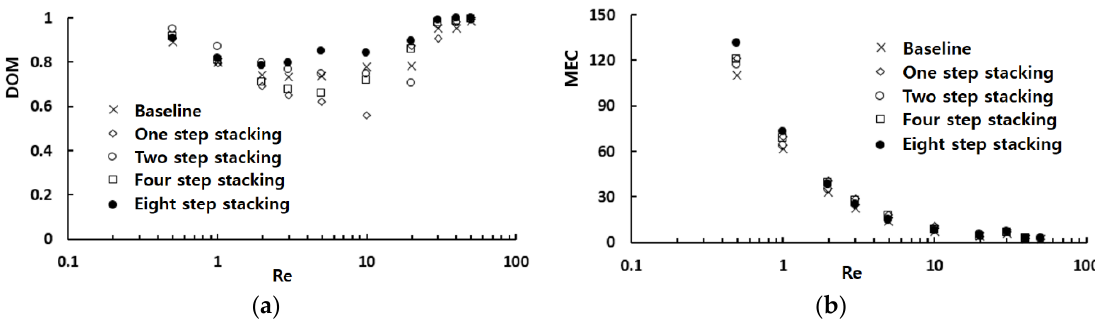
Figure 6. Effects of mixing unit stacking on the mixing performance. ( a ) DOM vs. Re. ( b ) MEC vs. Re.